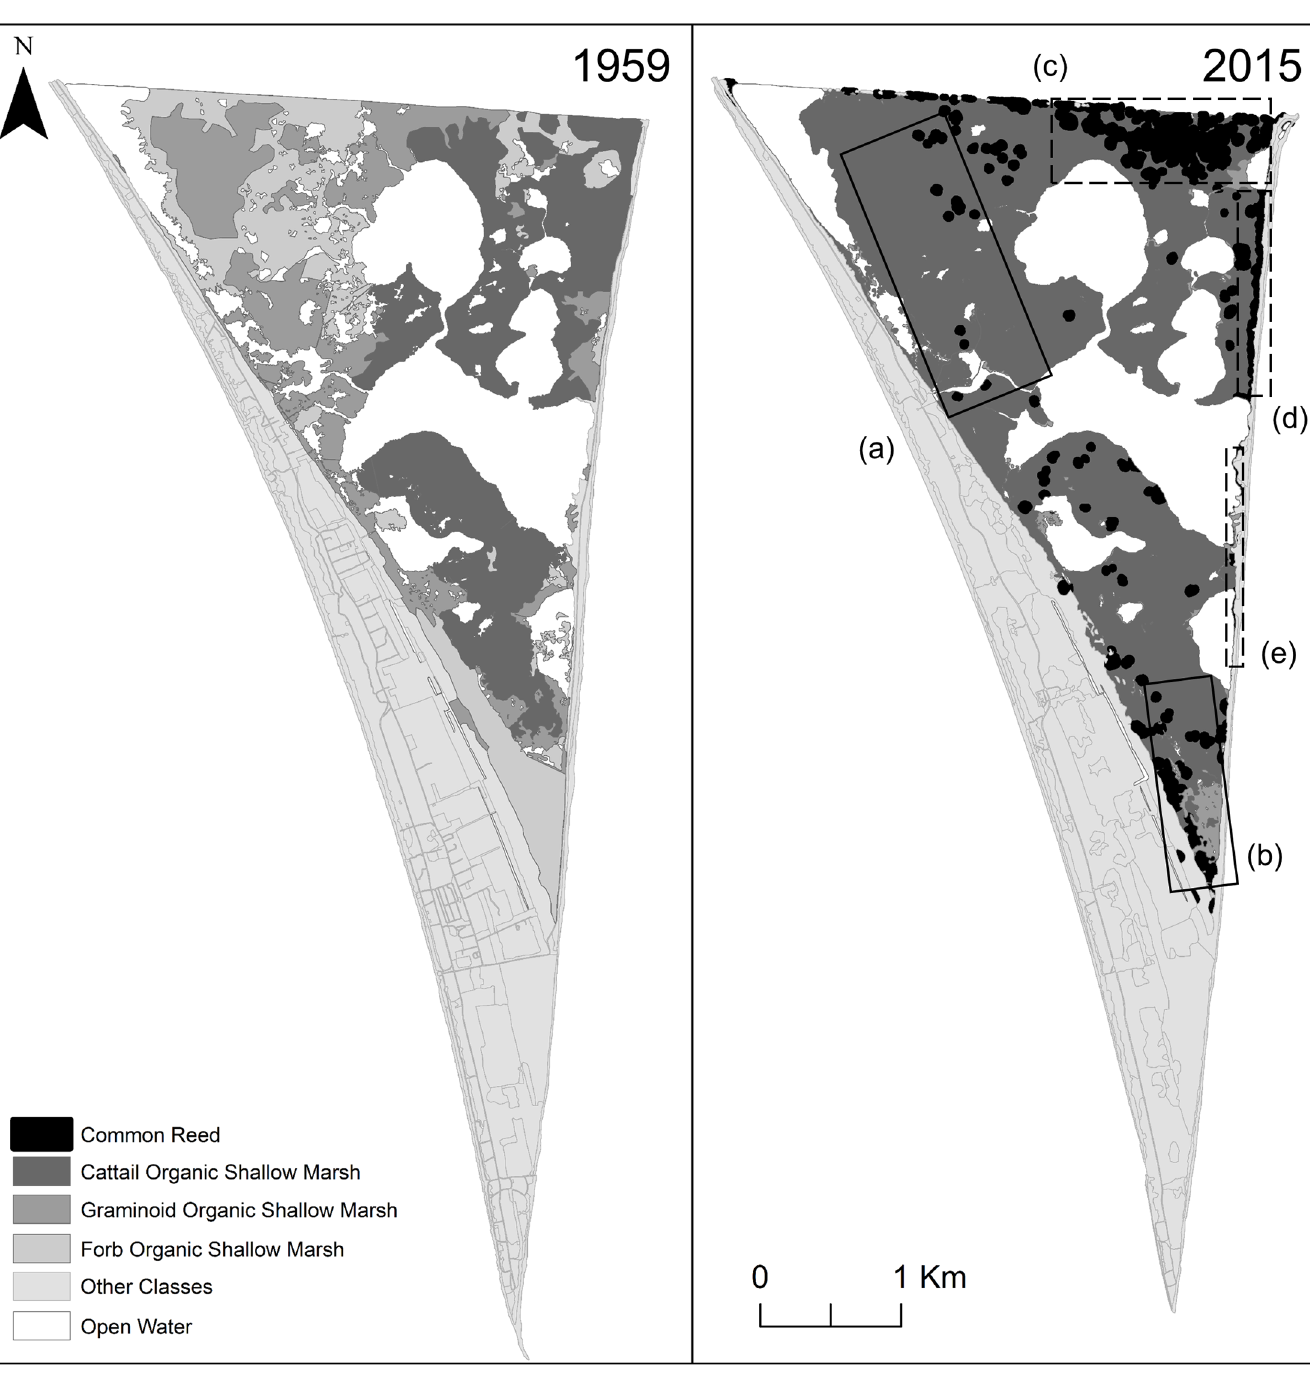
Fig 5. Change in marsh habitat in Point Pelee National Park between 1959 and 2015. (a) and (b) indicate hotspots of major habitat change and infilling within the marsh (solid-lined boxes). (c), (d), and (e) indicate hotspots of invasive common reed (dashed-lined boxes).